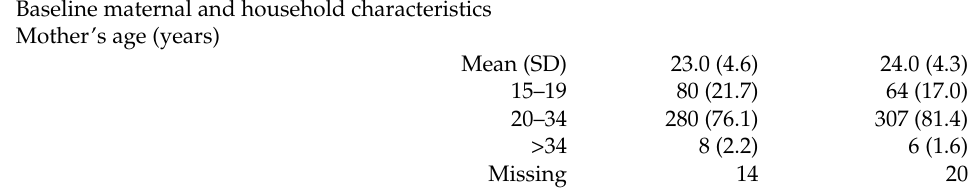
Table 1. Cluster, baseline maternal and household, and antenatal care and delivery characteristics by study arm.